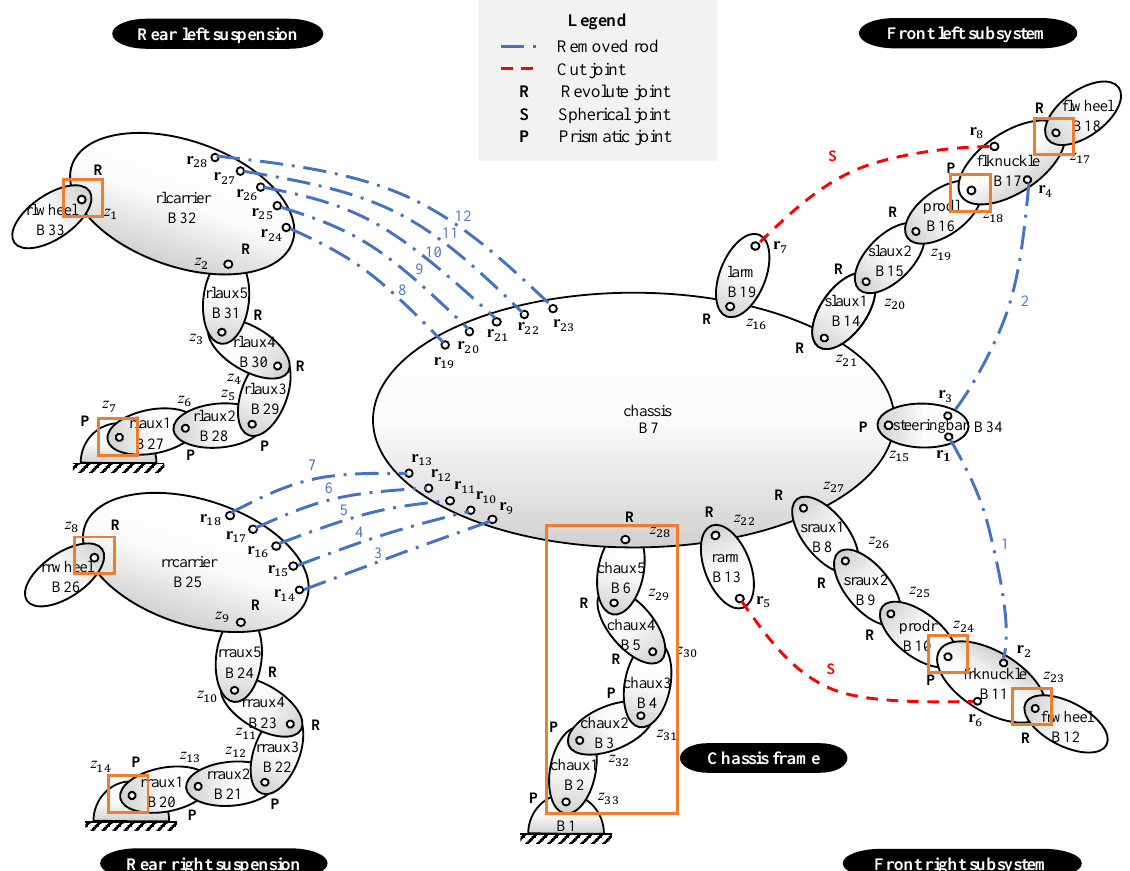
Figure 1. System structure of a 14 DOF vehicle